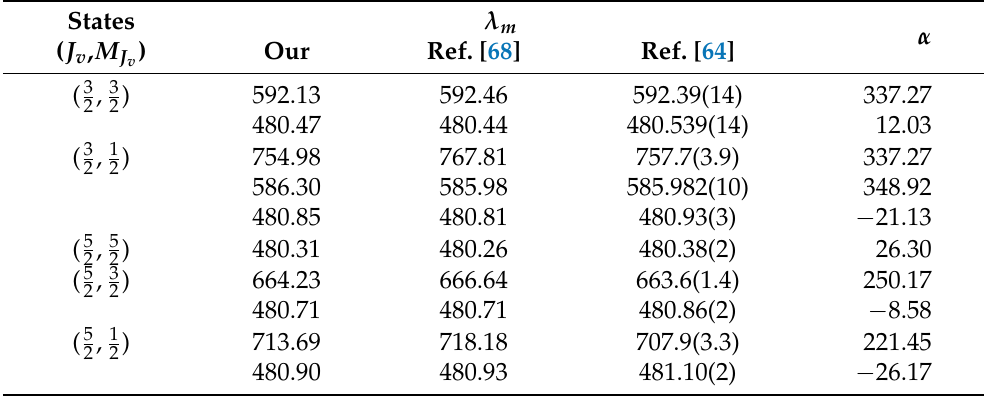
Table 4. Single-photon magic wavelengths ( λ m ) in nm and the corresponding polarizabilities ( α )